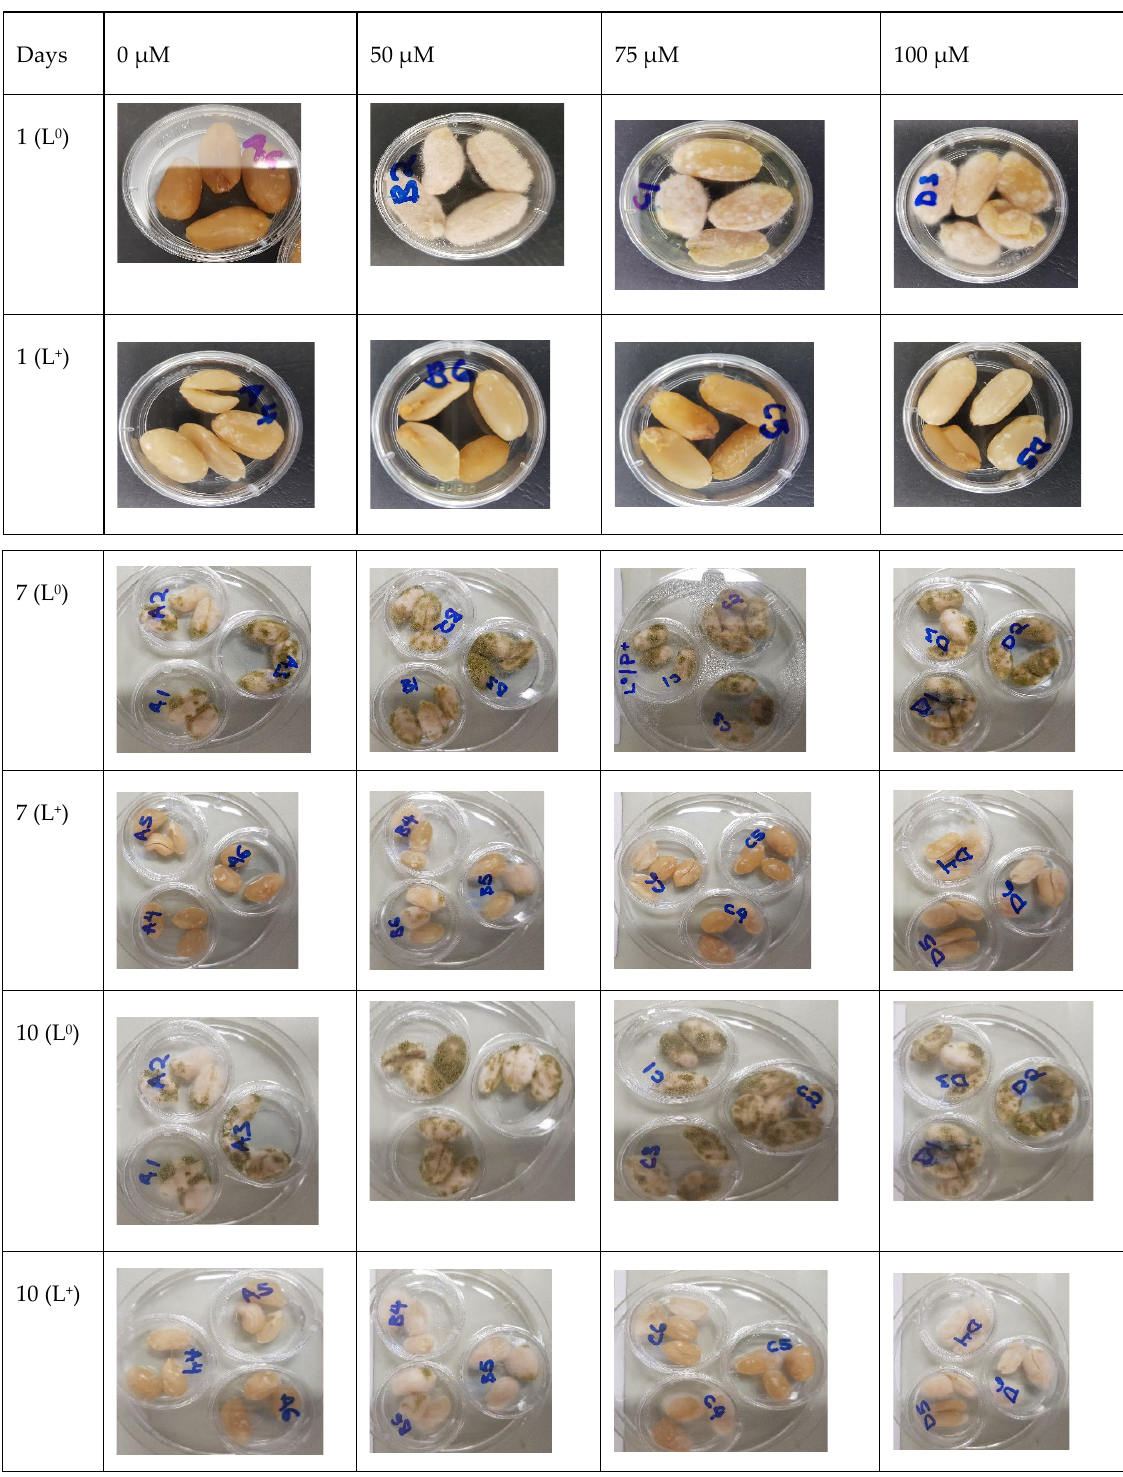
min levels resulted in AF-B1 accumulation of 0.087, 0.0066 and 0.0058 mg/kg, respectively (Figure 4), which were significantly lower ( p < 0.05) than levels observed in photosensi- tizer and light treatments.